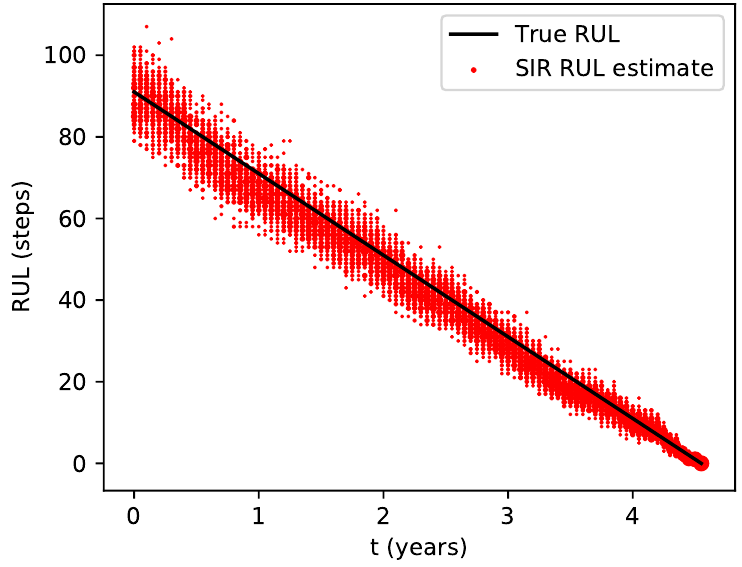
Figure 5. Remaining useful lifetime (RUL) prediction—sequential importance resampling (SIR) filter (dot size represents